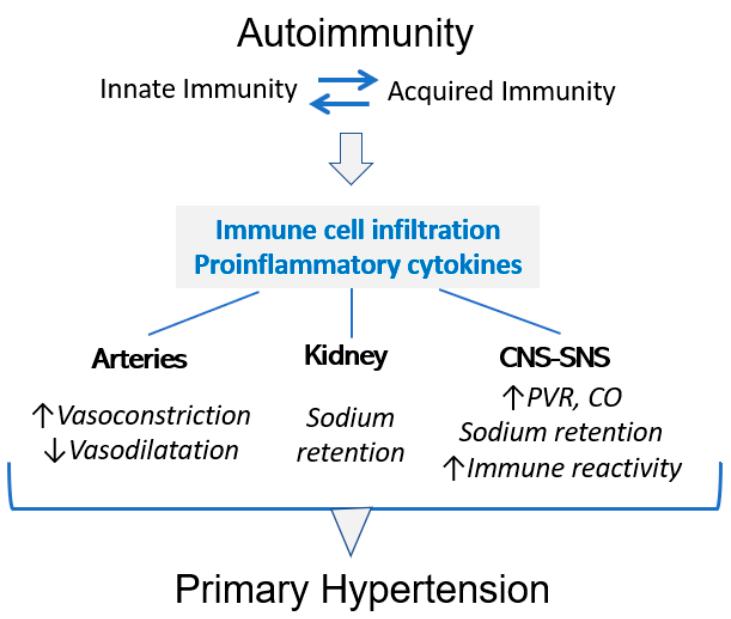
Figure 2. Autoimmunity in primary hypertension. Autoimmune reactivity is a central characteristic of primary hypertension. Prohypertensive immune reactivity has been demonstrated in the arterial adventitial layers, in the tubulointerstitial areas of the kidney and in central and sympathetic nervous systems. PVR: éripheral vascular resistance; CO: cardiac output.